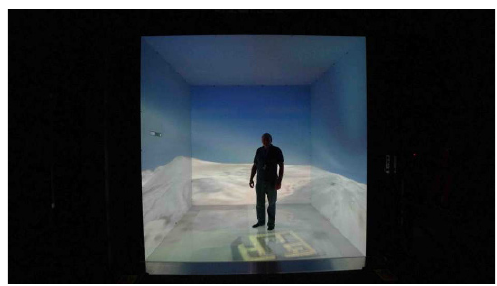
Figure 5. Cornea with door screen open. Content: Tom Levy, Kyle Knabb, and Jurgen Schulze. Photo: Tom DeFanti.